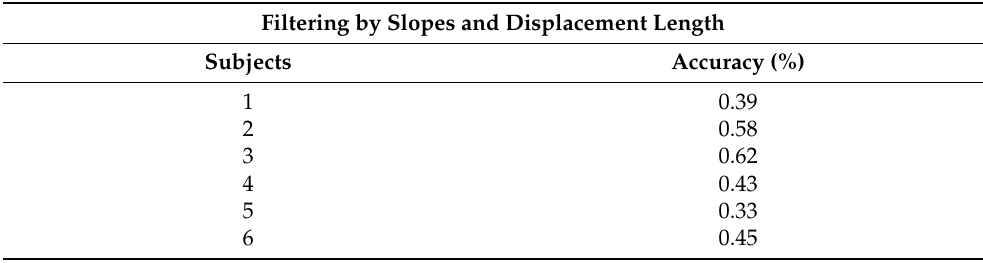
Figure 4. Results of signal filtering by displacement length. The red circle indicates the initial point of conforming to the slope and length, and the blue circle indicates the end point of conforming to the slope and length. Table 2. Accuracy of filtering by slopes and displacement length for six subjects.